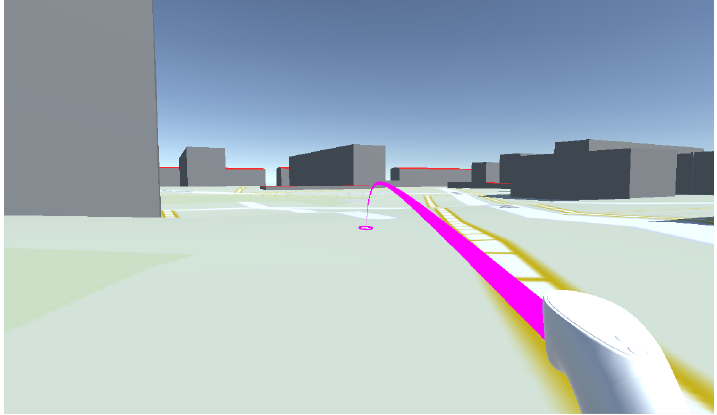
Figure 1. Standard VR point and click teleportation in our city